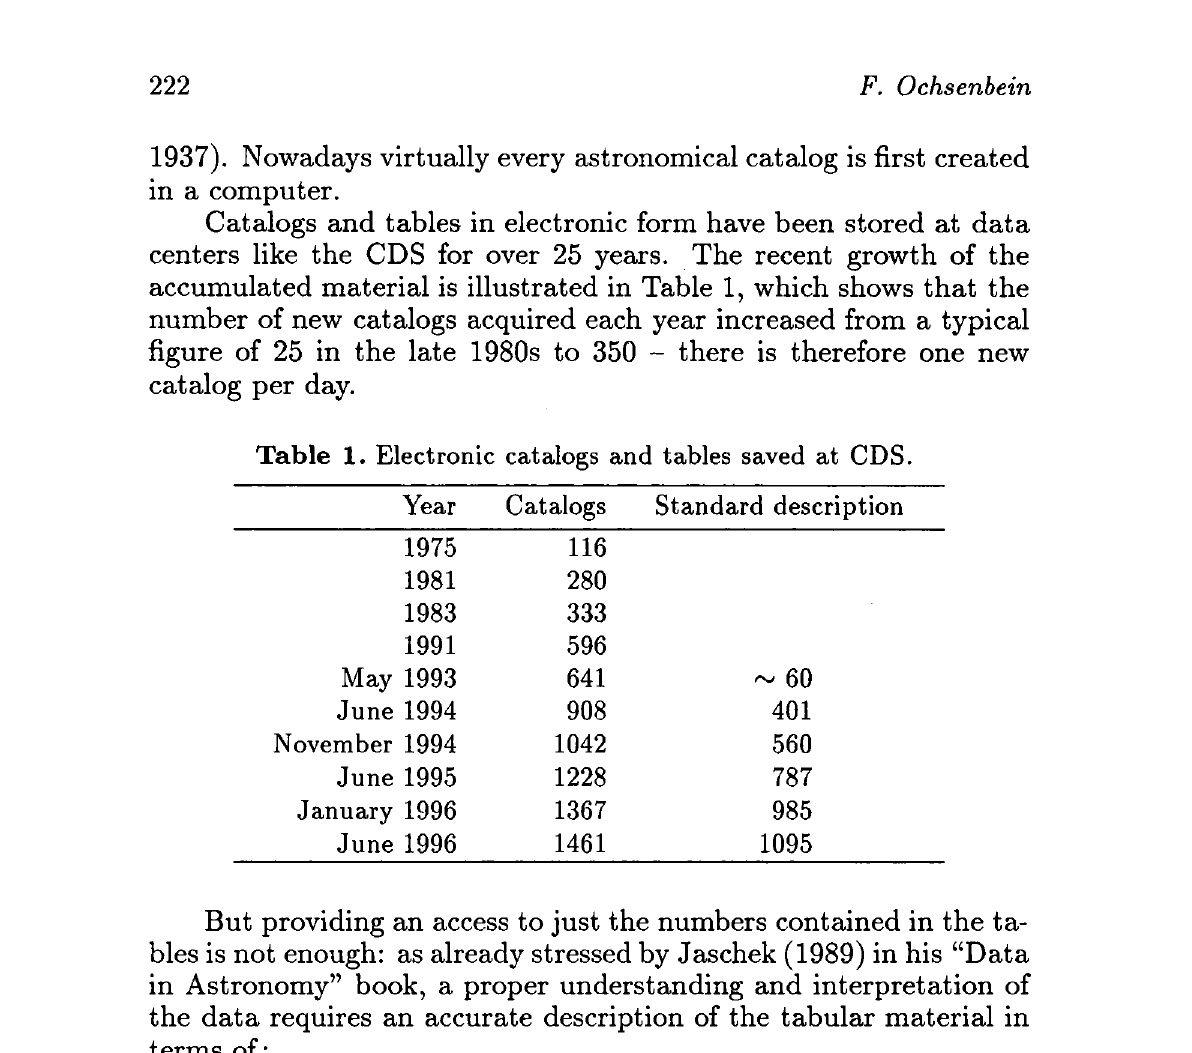
Table 1. Electronic catalogs and tables saved at